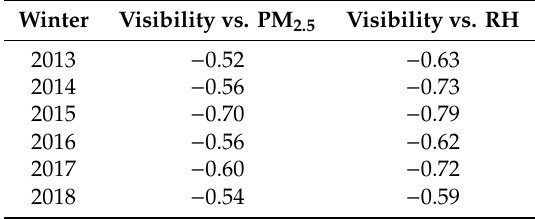
Table 1. Correlation coe ffi cients of daily visibility with PM 2.5 concentrations and RH in Nanjing during wintertime of 2013–2018 (passing the confidence level of